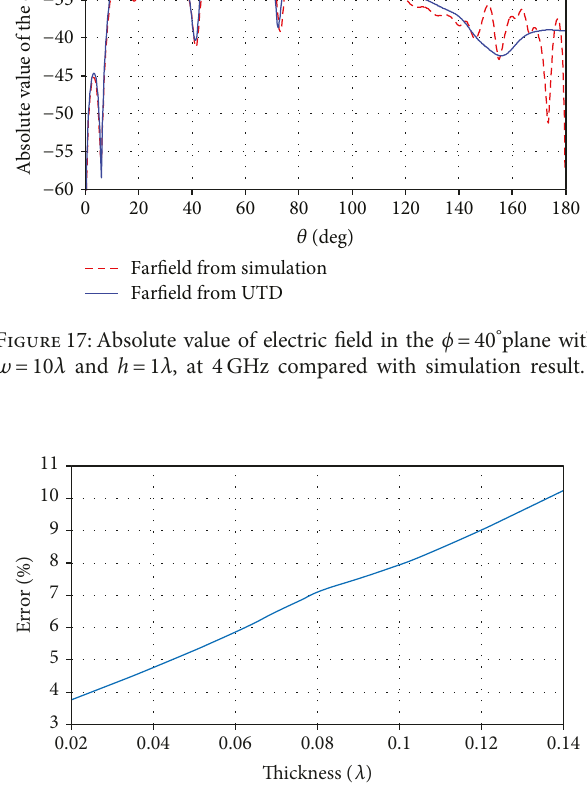
Figure 18: Accuracy of the proposed UTD solution when comparing with the numerical results from simulation versus the variation of thickness of material